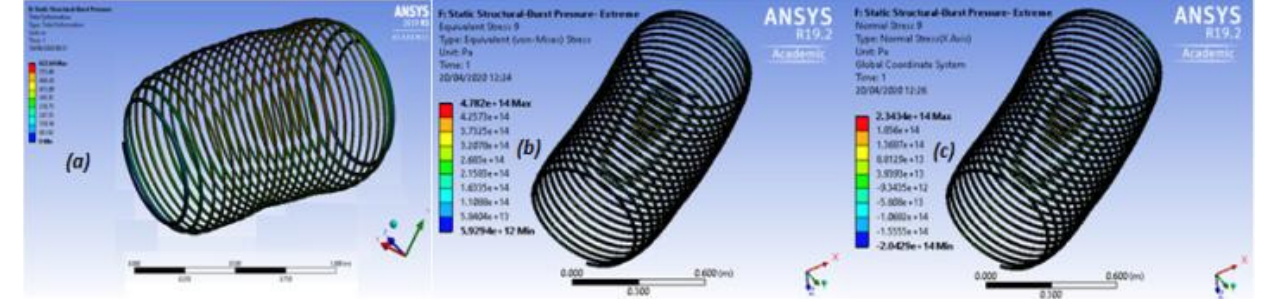
Figure 11. Burst loading on the helical spring reinforcement under extreme conditions showing ( a ) total deformation, ( b ) equivalent von Mises stress and ( c ) normal stress (ends are free without end fittings in this